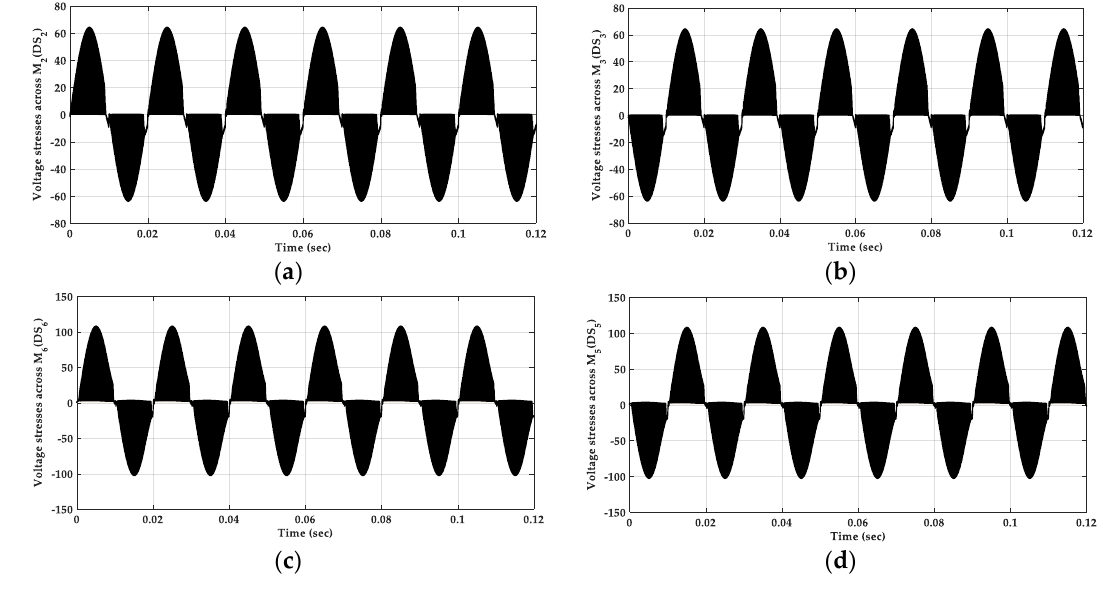
Figure 7. Voltage stresses across ( a ) M 2 ( D S 2 ); ( b ) M 3 ( D S 3 ); ( c ) M 5 ( D S 5 ); ( d ) M 6 ( D S 6 ).